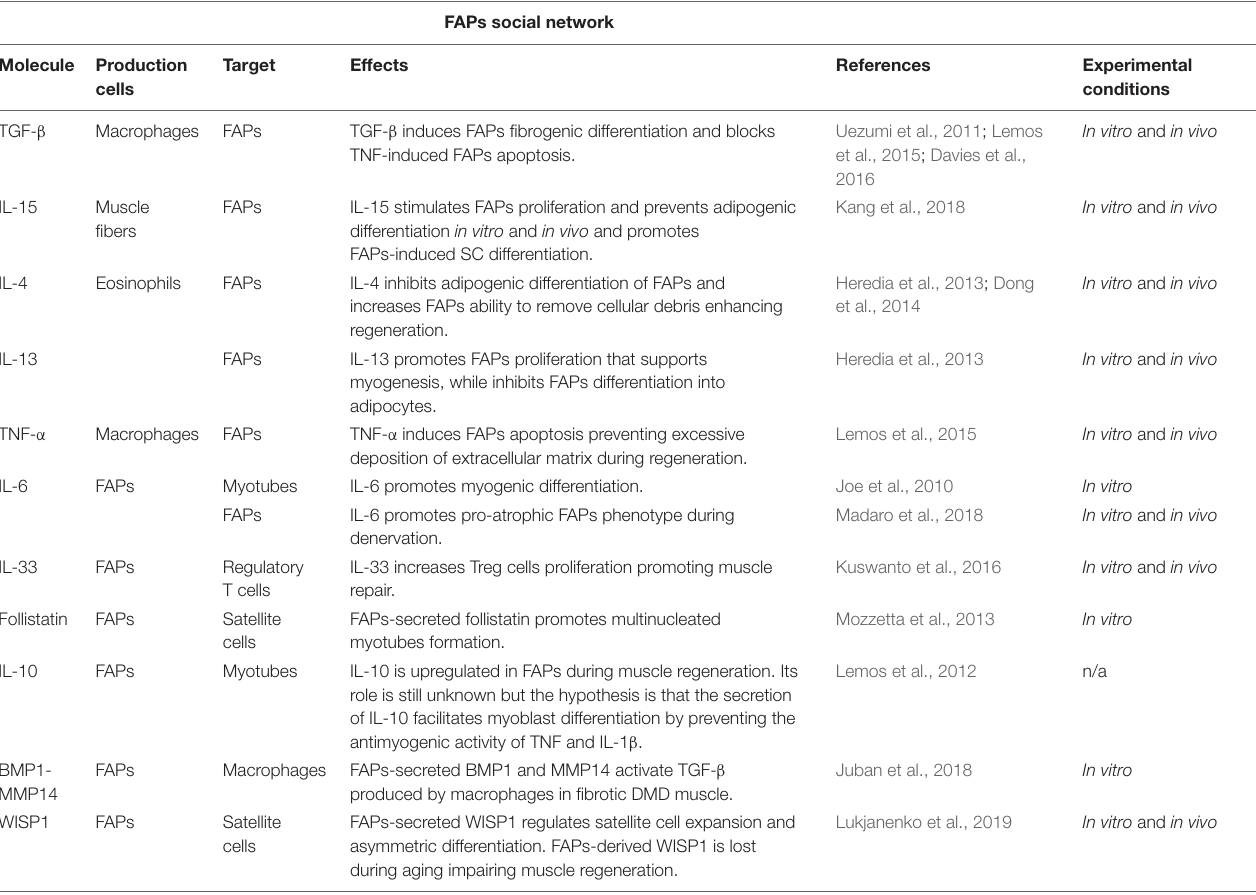
TABLE 1 | Schematic table illustrating the principal molecules, the producing and target cells, and the corresponding biological effects, that have been shown to act on, or be released by,